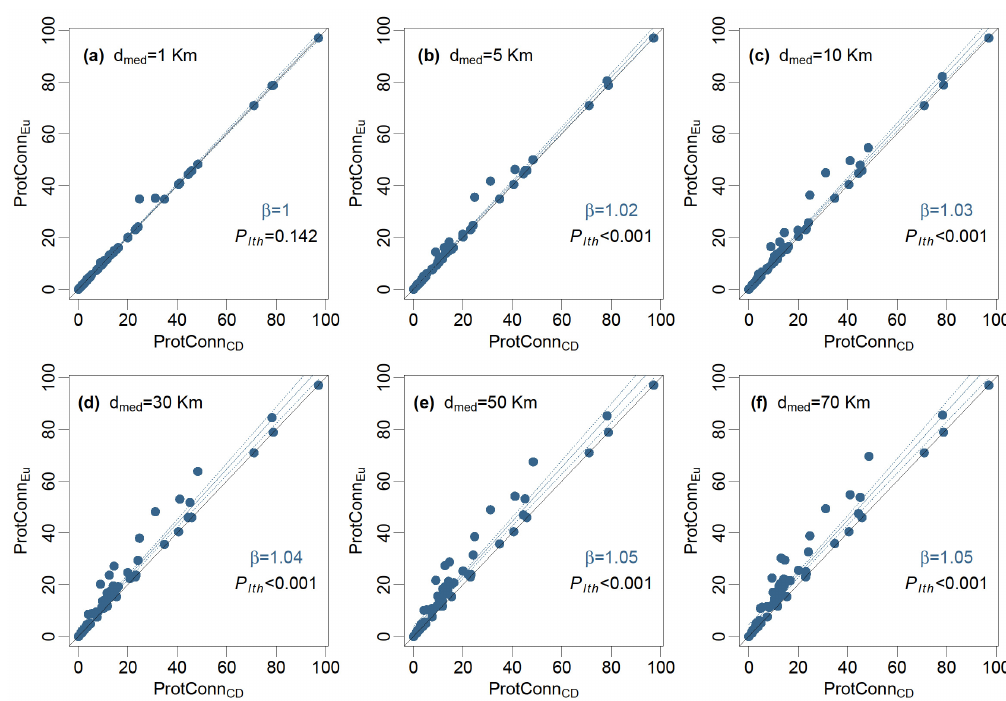
Figure 1. Linear test hypothesis (lth) for the 1:1 relationship between ProtConn Eu and ProtConn CD . Dispersal distances refer to: ( a ) d med = 1 km, ( b ) d med = 5 km, ( c ) d med = 10 km ( d ) d med = 30 km, ( e ) d med = 50 km, and ( f ) d med = 70 km. The black continuous line denotes the 1:1 expected slope at each d med ( β 0,1 ) and the blue continuous line the regressed slope between ProtConn Eu and ProtConn CD values. Confidence intervals of the regressions are shown in blue hatched lines.